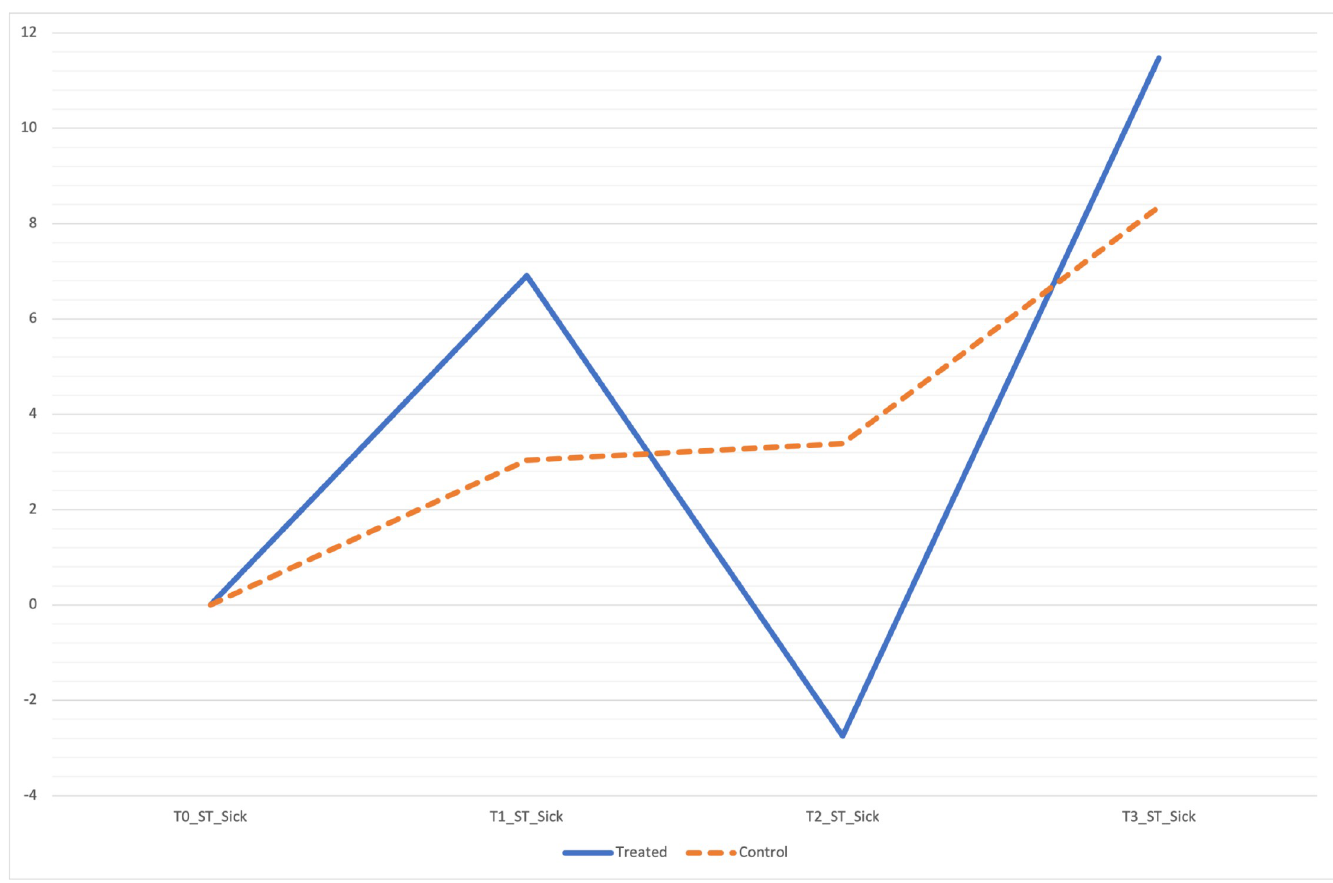
Fig 3. Percentage increase in ST over time between two